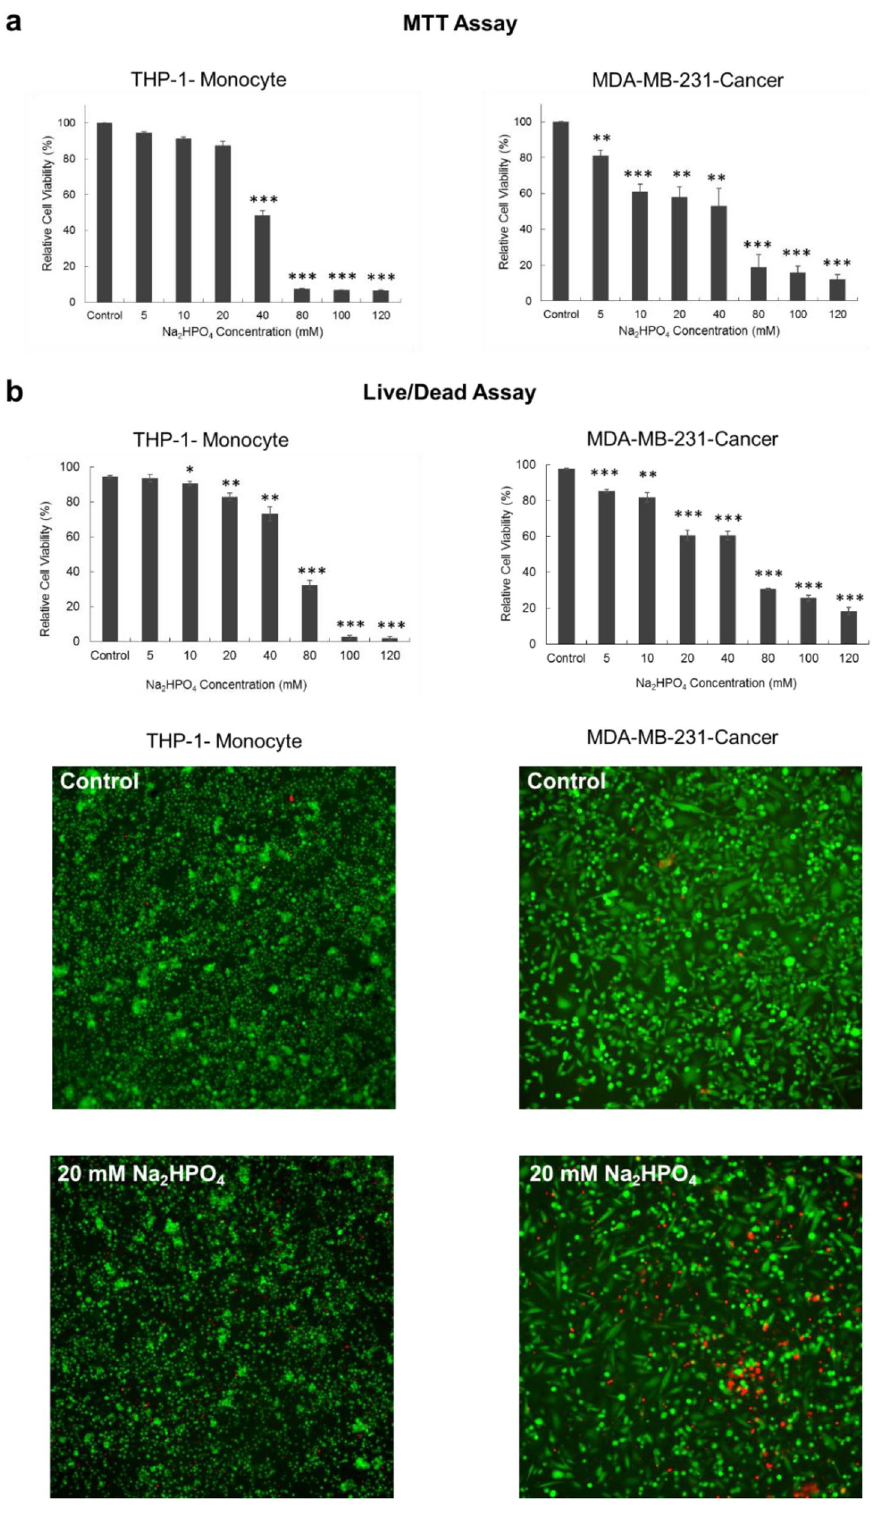
Figure 3. Toxicity of Sodium Phosphate Dibasic (Na 2 HPO 4 ) to THP-1, human monocyte cell line and MDA-MB-231, human breast cancer cell line, evaluated via ( a ) MTT assay and ( b ) live/dead assay after 48 h of incubation with the compound. At low concentrations (< or = 20 mM), Na 2 HPO 4 is more toxic to MDA-MB-231 cells than it is to THP-1 cells. At high concentrations (> 20 mM), Na 2 HPO 4 is toxic to both cell types. For fluorescence images, live cells are stained in green while dead cells are stained in red. Experiments were done in triplicate and the sample number for each replicate is